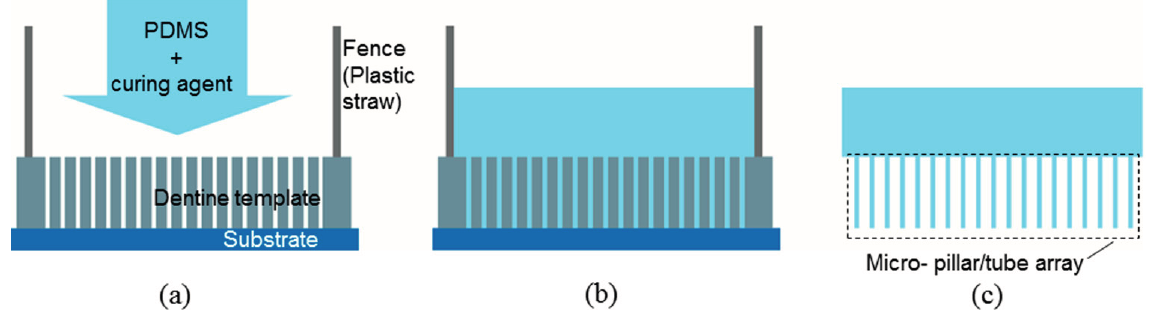
Figure 7. Schematics of fabrication process: ( a ) casting; ( b ) curing at 70 °C for 100 min; ( c )